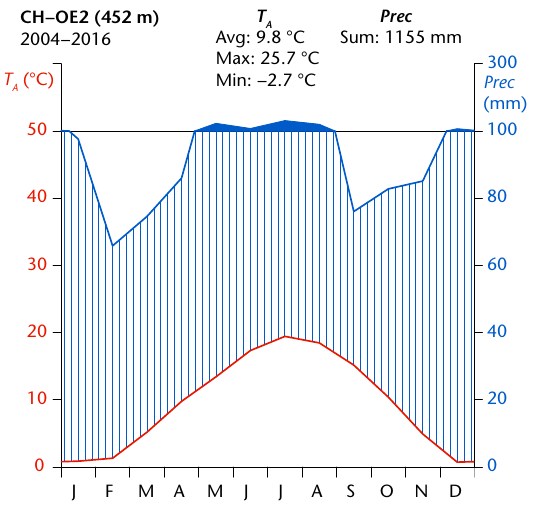
Figure 1. Climate diagram after Walter and Lieth (1960) for the time period of 2004 to 2016. The monthly average air temperature ( T A ) and the monthly total precipitation (Prec) are shown in red and blue, respectively. Average (Avg), average minimum (Min) and average maximum (Max) annual T A and average annual total (Sum) precipitation are listed at the top of the figure. Note that the scale of the right axis changes above